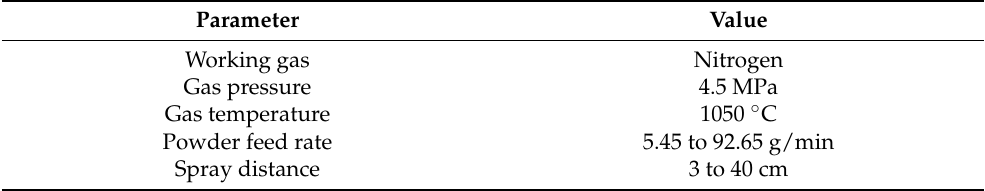
Table 1. Cold spray processing parameters